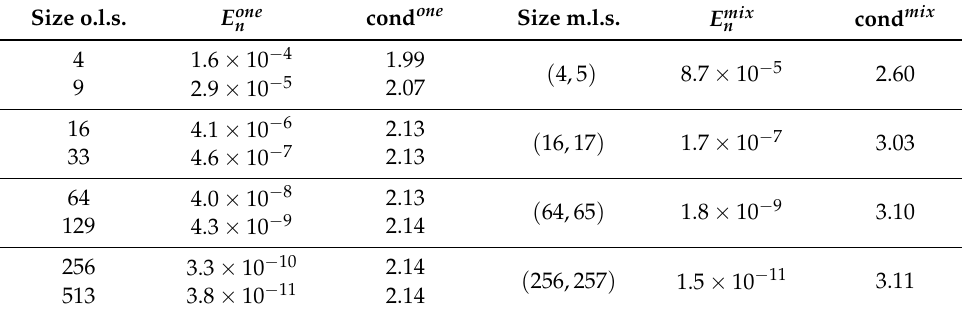
Table 2. Example 2: Ordinary and Mixed Nyström methods. Size o.l.s.